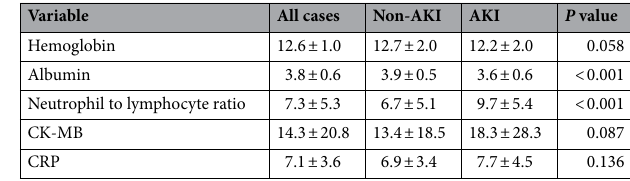
Table 3. Laboratory findings. AKI: acute kidney injury, CK-MB: creatine kinase MB, CRP: C-reactive